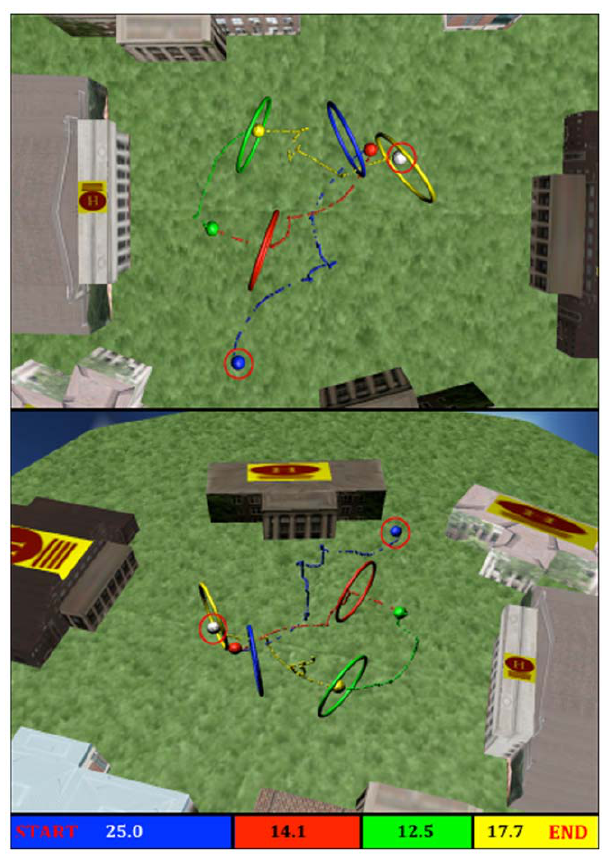
Figure 3. Speed, accuracy, and continuity of control are depicted in a characteristic run performed by Subject 1 (Session 5, Trial 9, Targets 4–7). Only one target was visible to the subject at any given time. The presentation of a new ring occurred 1.5 seconds after a ring hit. The helicopter’s position upon ring presentation is represented by a larger coloured sphere. Smaller coloured spheres represent the position of the helicopter sampled every 30 milliseconds. The subject started with the blue ring, and progressed through red, green, and yellow rings as illustrated by the colour bar on the bottom of the figure. The overall duration of this continuous portion of the run was 69.53 seconds.